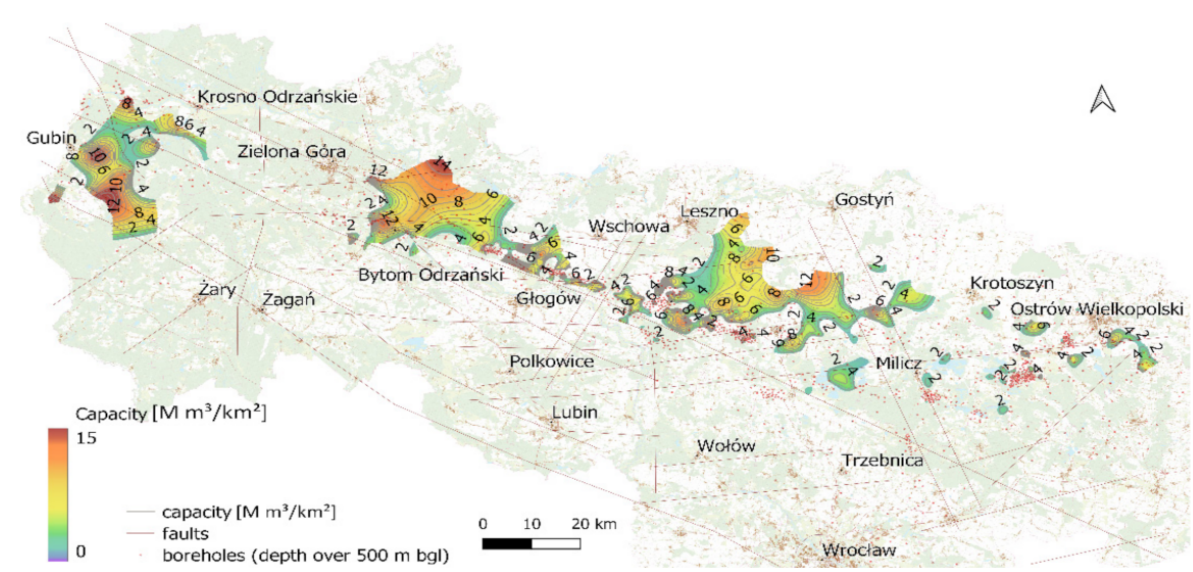
Figure 10. The storage capacity of liquid fuels in the rock salt layer in the Fore-Sudetic Monocline (strategic